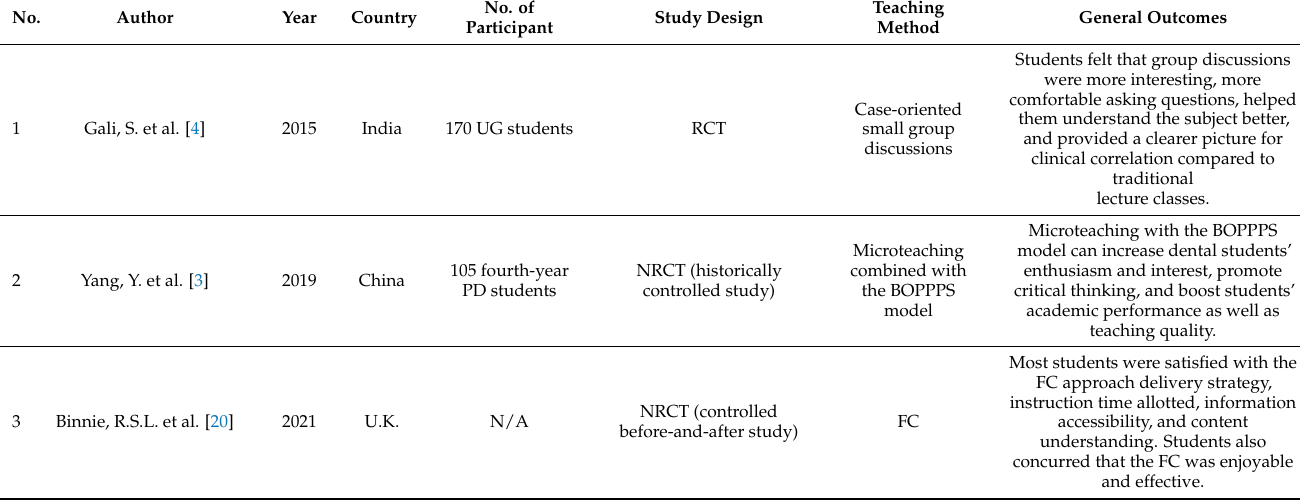
Table 2. Characteristics of the selected primary